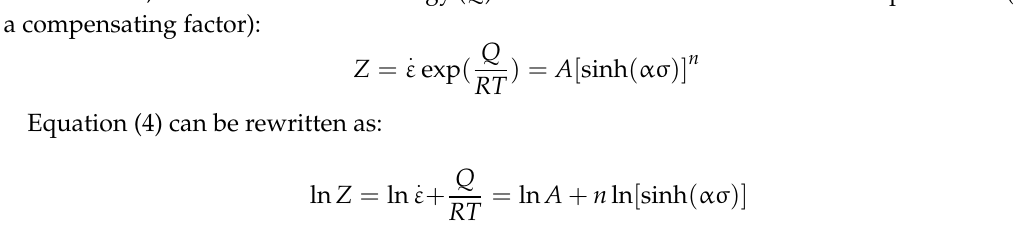
Figure 3. Plots of ( a ) ln[sinh( ασ )] vs. T − 1 , ( b ) ln[sinh( ασ )] vs. ln